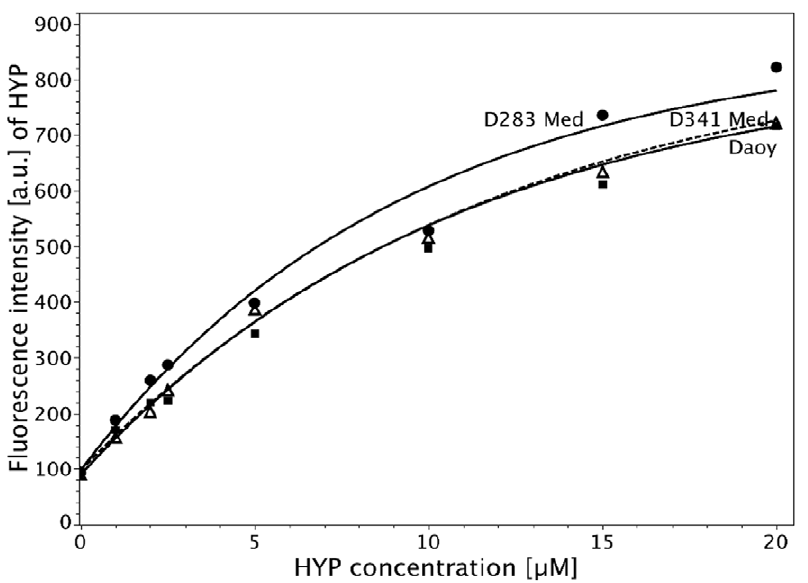
Figure 2. Concentration-dependent fluorescence intensity of HYP in D283 Med (dotted line), D341 Med (dashed line), and Daoy cells (continuous line) determined by fluorescence microscopy after 2 h incubation at 37 6 C. Mean values of the individual measurements for D283 Med, D341 Med Daoy are plotted as filled circles, filled squares, and open triangles, respectively, and the fitted curves are calculated according to Formula (1). The parameter values for b , a , and A are: D283 Med: b =97.6 [a.u.], a =0.11 [1/[ m M]], A =867.8 [a.u.]; R 2 ~ 98 : 1% ; D341 Med: b =97.6 [a.u.], a =0.09 [1/[ m M]], A =866.2 [a.u.]; R 2 ~ 99 : 3% ; and Daoy: b =89.7 [a.u.], a =0.09 [1/[ m M]], A =832.5 [a.u.]; R 2 ~ 99 : 7% .